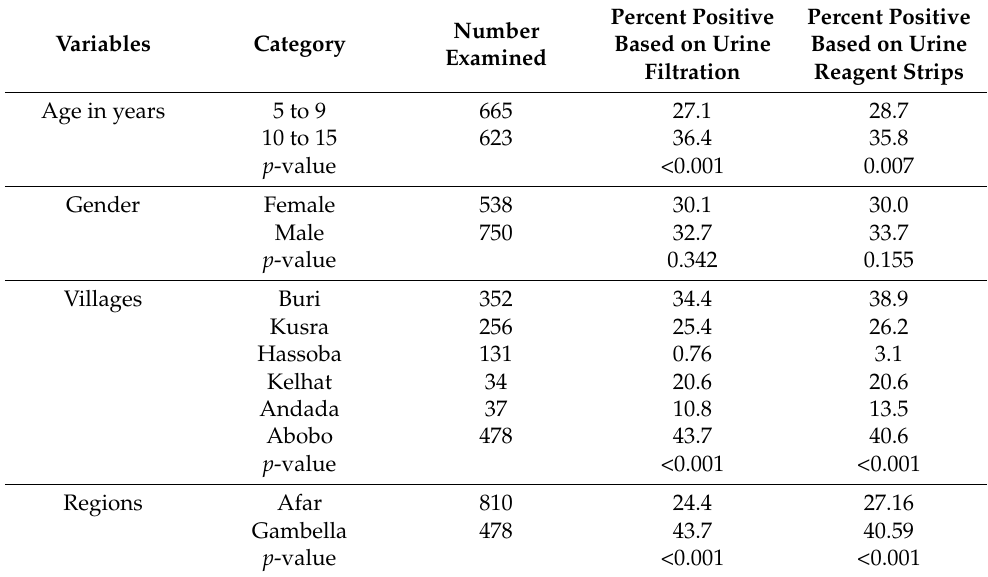
Table 1. Prevalence of Schistosoma haematobium infection among school-age children in Afar and Gambella regional states of Ethiopia, October 2021 to April 2022. Number Variables Category